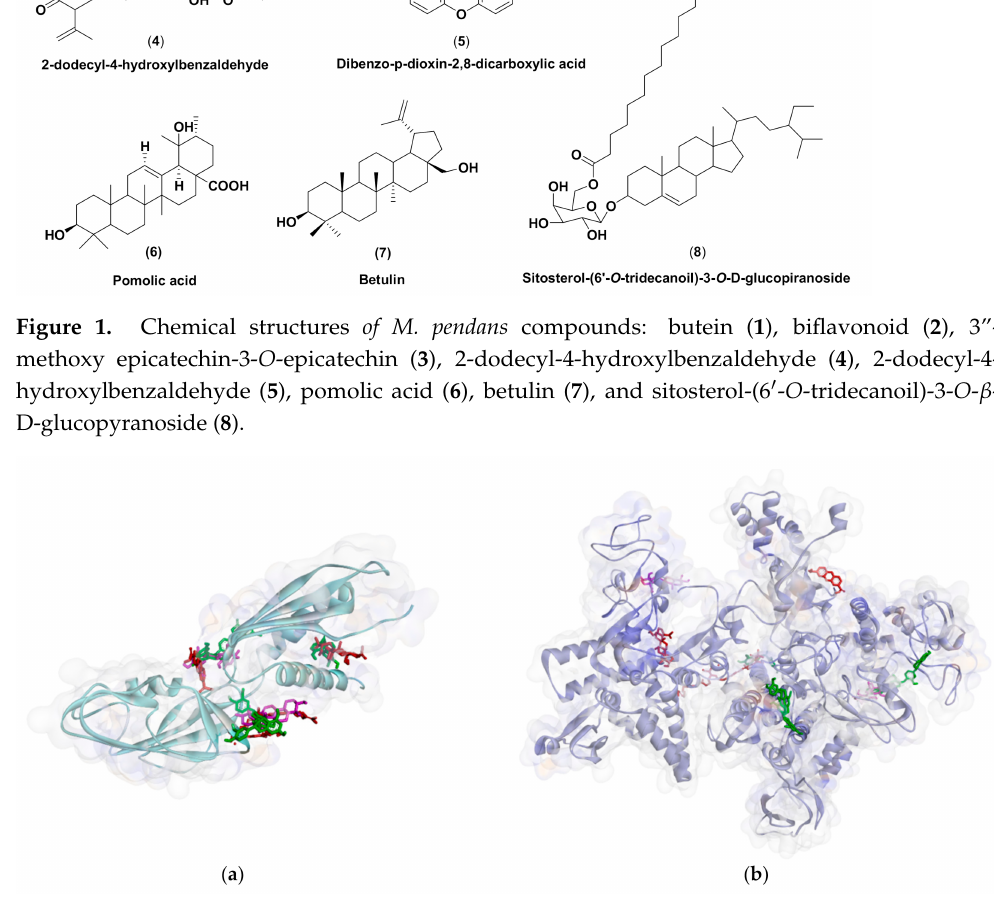
Figure 2. Ligand positions in RNA polymerase alpha ( a ), and RNA polymerase beta ( b